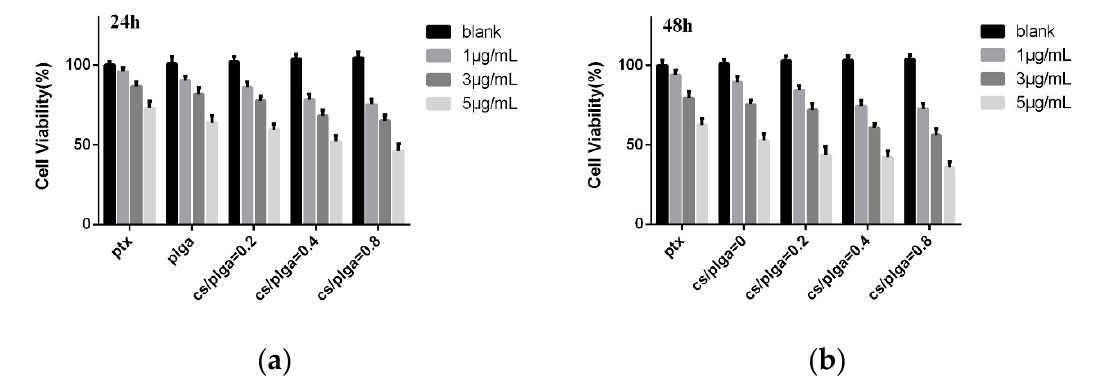
Figure 8. Cell viability of MDA-MB-231 cells: ( a ) 24 h and ( b ) 48 h.